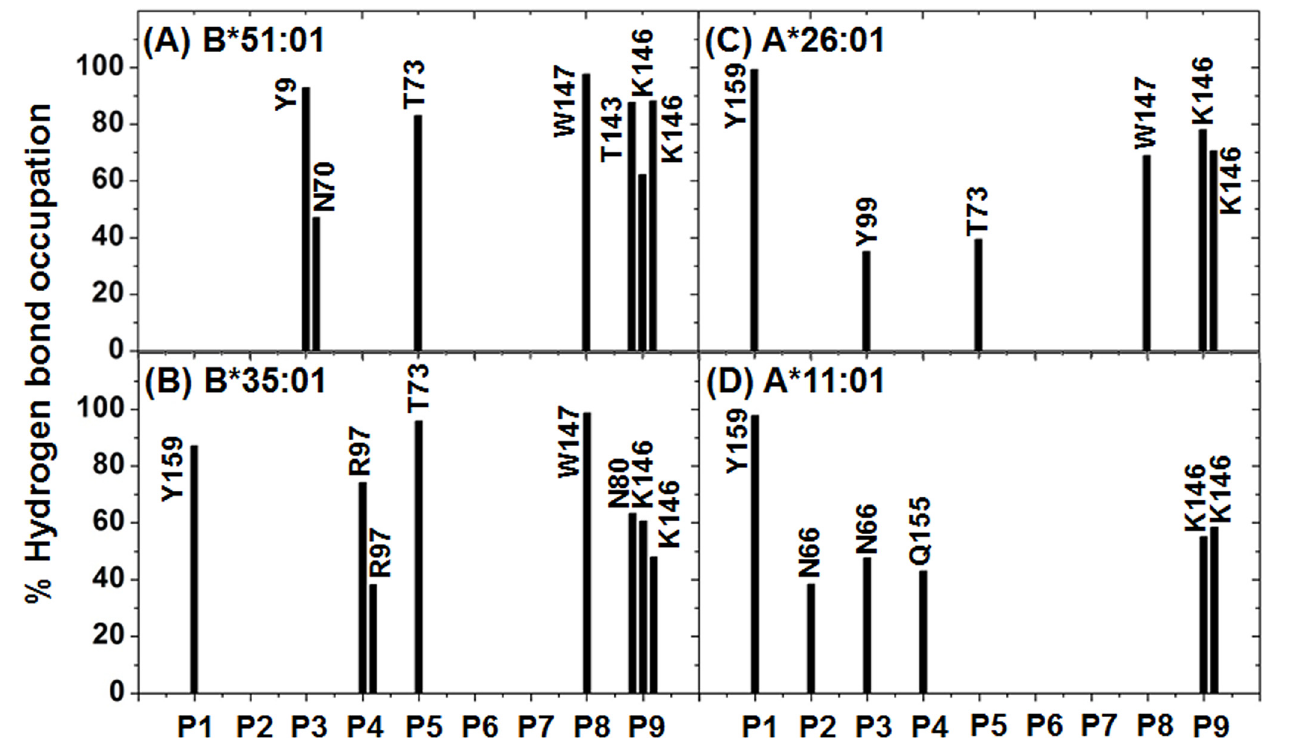
Fig 5. Hydrogen bond interactions. The percentage occupancy of H-bonds averaged over the last 25 ns of simulation time between the nine residues (P1 – P9) of the MICA-TM peptide and the HLA residues for the four complexes.